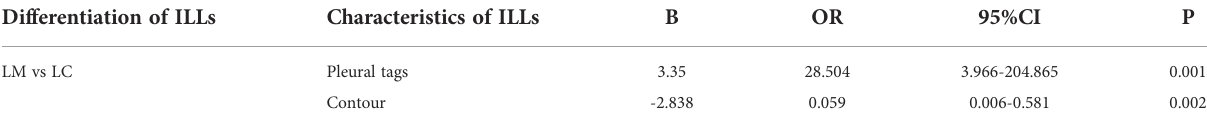
TABLE 3 Multivariate analysis results of diagnostic model for differentiation LM from LC in training